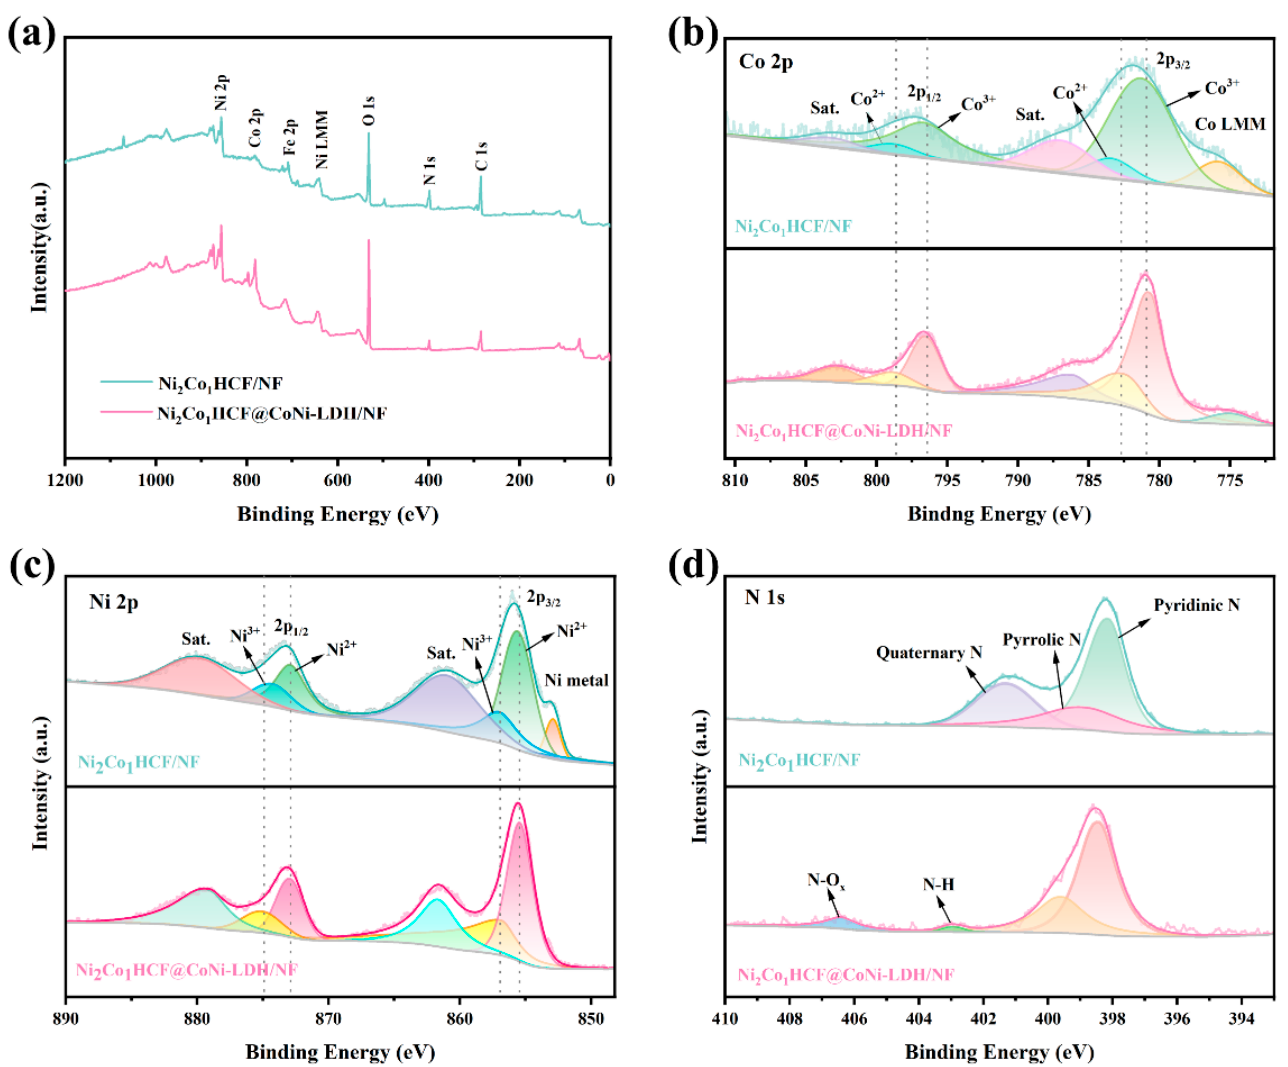
Figure 4. XPS spectra of ( a ) survey spectrum; ( b ) Co 2p peak; ( c ) Ni 2p peak; ( d ) N 1s peak of the Ni 2 Co 1 HCF/NF and Ni 2 Co 1 HCF@CoNi-LDH/NF composites.